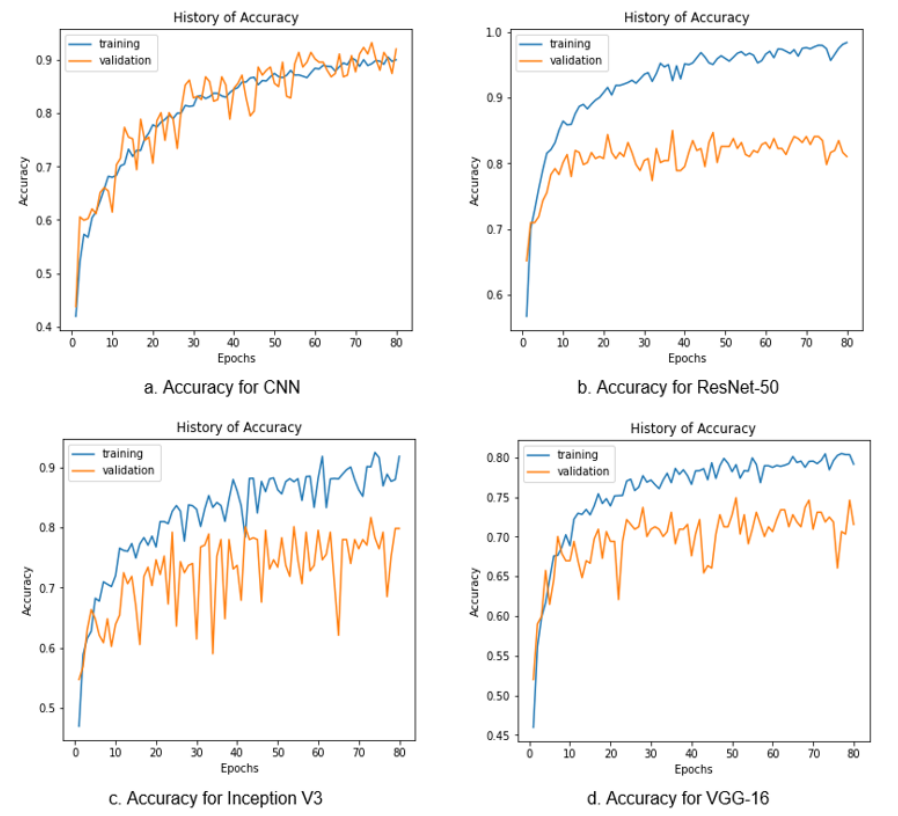
Figure 9. Accuracy Graphs for the CNN, ResNet-50, Inception V3, and